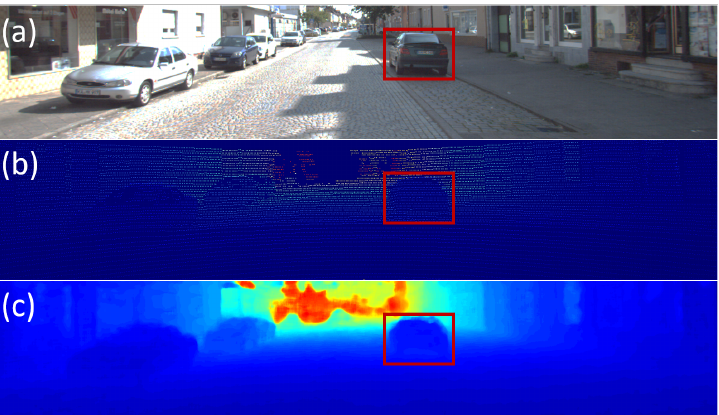
Figure 4. Visualization of dense operation. ( a ) RGB image; ( b ) LiDAR depth and intensity; ( c ) dense LiDAR depth and intensity after dense operation. Edge structure of the vehicle inside the red box in the dense LiDAR feature map is clearer than the raw LiDAR feature map, benefiting the extraction of the significant calibration feature.